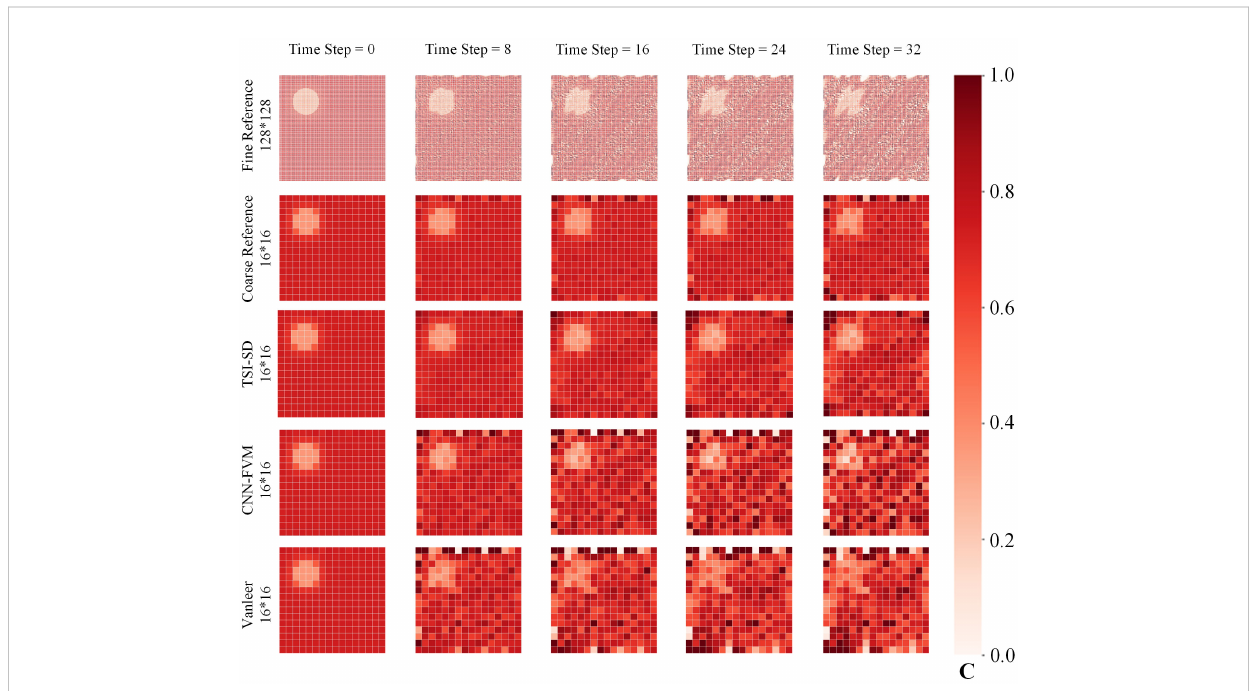
FIGURE 6 Visualization of evolution prediction effect of an initial concentration fi eld under different models after 32 iterations. The fi rst row represents the change in the concentration fi eld calculated after 32 steps using a traditional 128*128 high-resolution solver. The second row represents the transformation of the 128x128 high-resolution solver solution into a 16x16 training set. The third row represents the prediction results of our model after training. The fourth row represents the prediction results of the CNN-FVM solver. The fi fth row uses a traditional 16*16 low-resolution solver to calculate the change in the concentration fi eld after 32 steps.